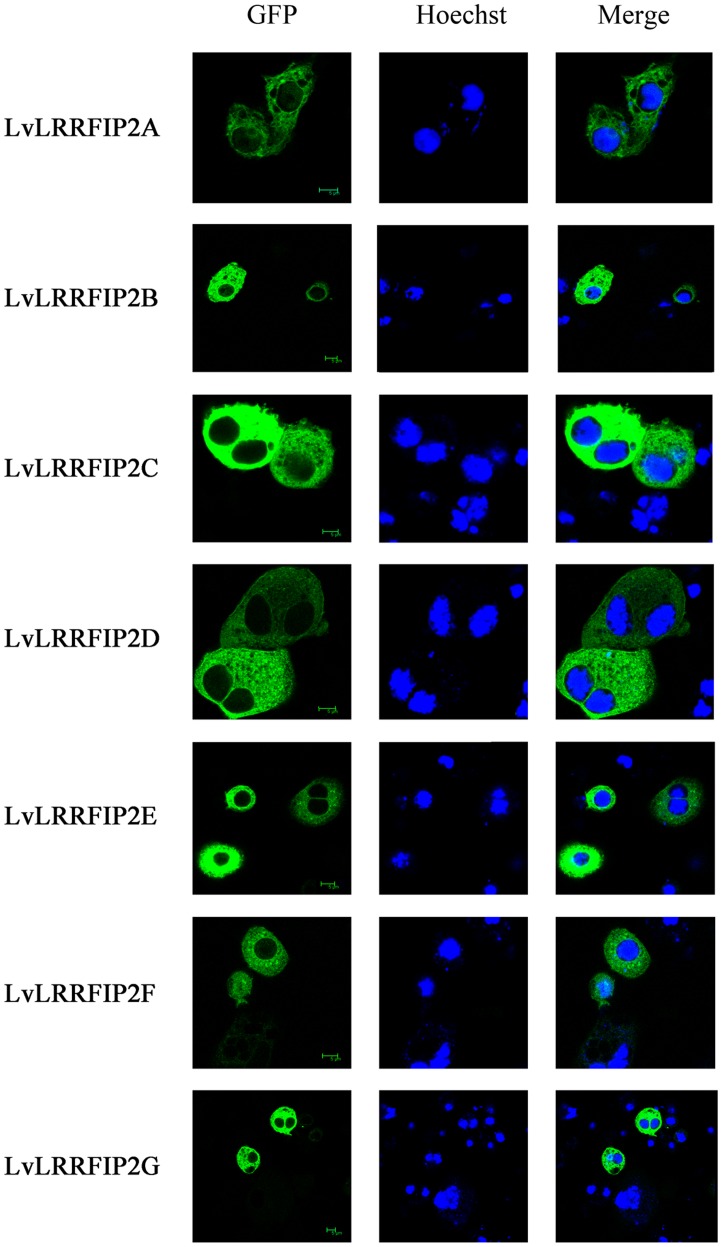
Subcellular localizations of LvLRRFIP2s.
Drosophila S2 cells were transfected with GFP fusion proteins of pAcLvLRRFIP2s. At 48 h post-transfection, the cells were observed using a Leica laser scanning confocal microscope.